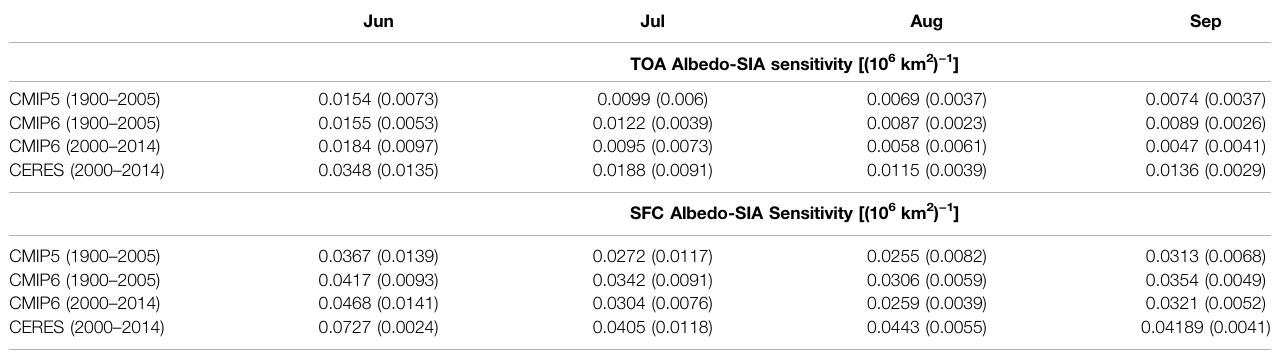
TABLE 3 | Monthly TOA and surface (SFC) albedo sensitivities to sea ice area in June through September.